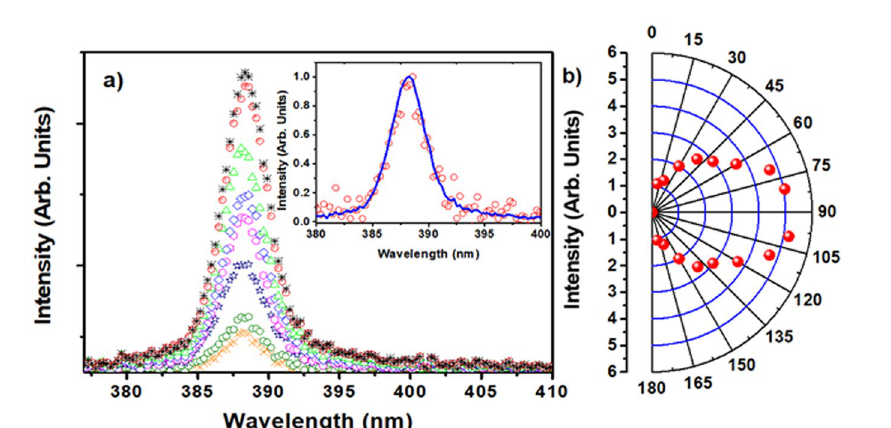
Figure 4. ( a ) Averaged spectral emission from below (black dashed line –excitation energy 0.2 mJ – and red long dashed line, excitation energy 0.6 mJ) to above (blue continuous line– excitation energy 2.4 mJ) threshold for sample CA-ZnO-Ag; ( b ) Emission spectral linewidth (blue squares) and emission intensity (black circles) dependence on excitation energy at 5 Hz. The dashed straight line indicates the threshold energy on the horizontal scale. ( c ) a single shot spectrum (excitation above threshold), in which spikes (see inset in c ) can be seen.